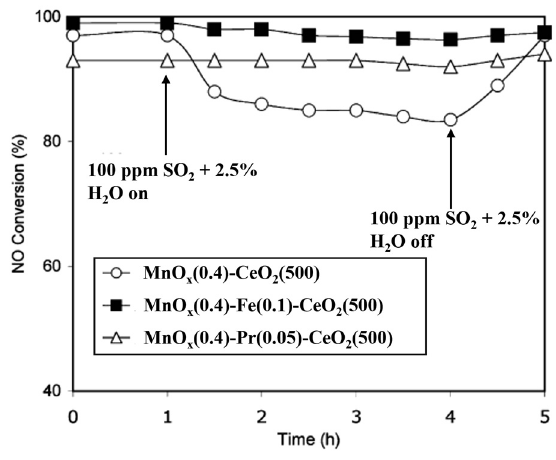
Figure 13. The effects of SO 2 and H 2 O on the SCR activities of MnO x (0.4)–CeO 2 (500)-based catalysts (Reaction conditions: 0.2 g catalyst, [NH 3 ] = [NO] = 1000 ppm, [O 2 ] = 2%, He = balance and total flow rate = 100 mL / min, T = 150 °C). (Reproduced with permission from Reference [35], Copyright 2004, Elsevier.).